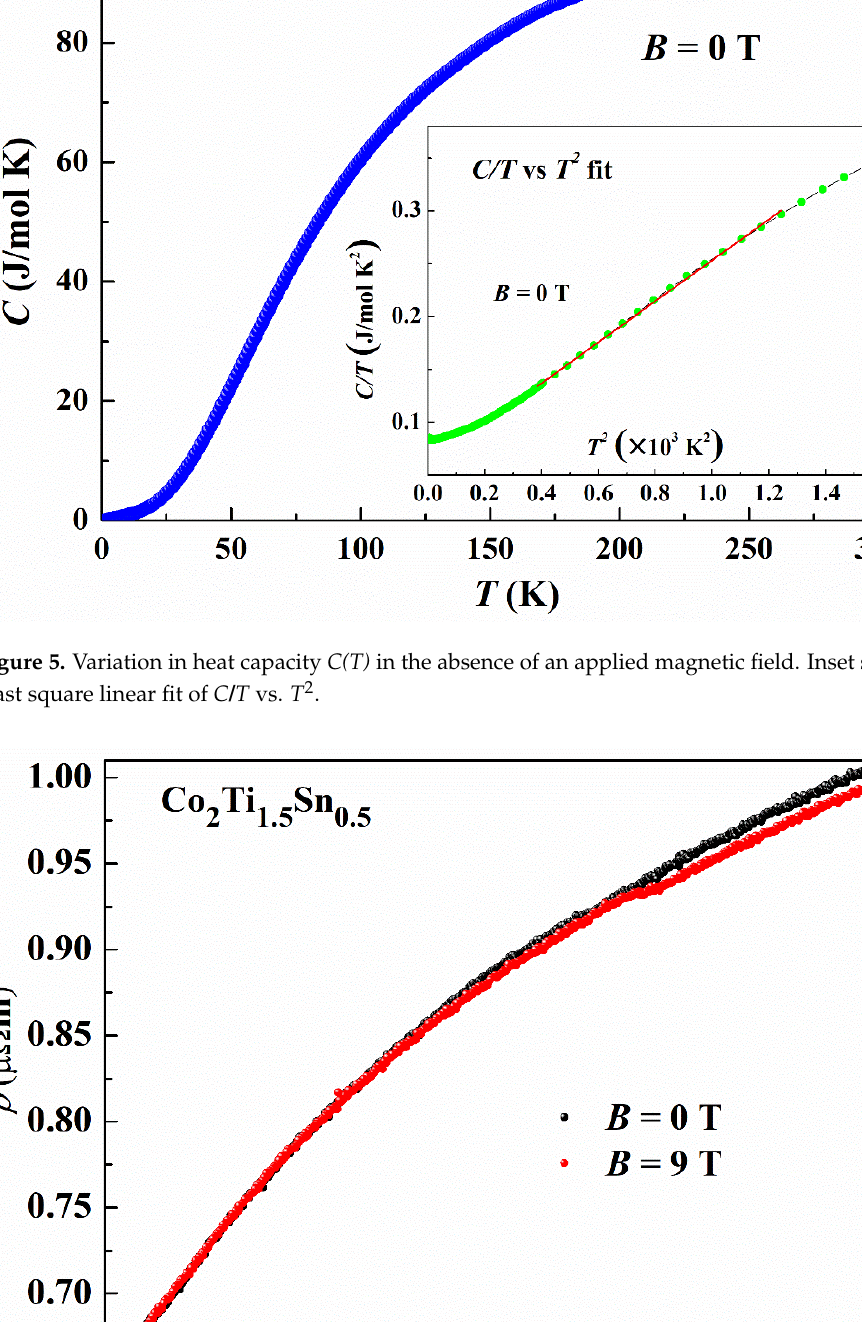
2 Ti 1.5 Sn 0.5 in B = 0 T and B = 9